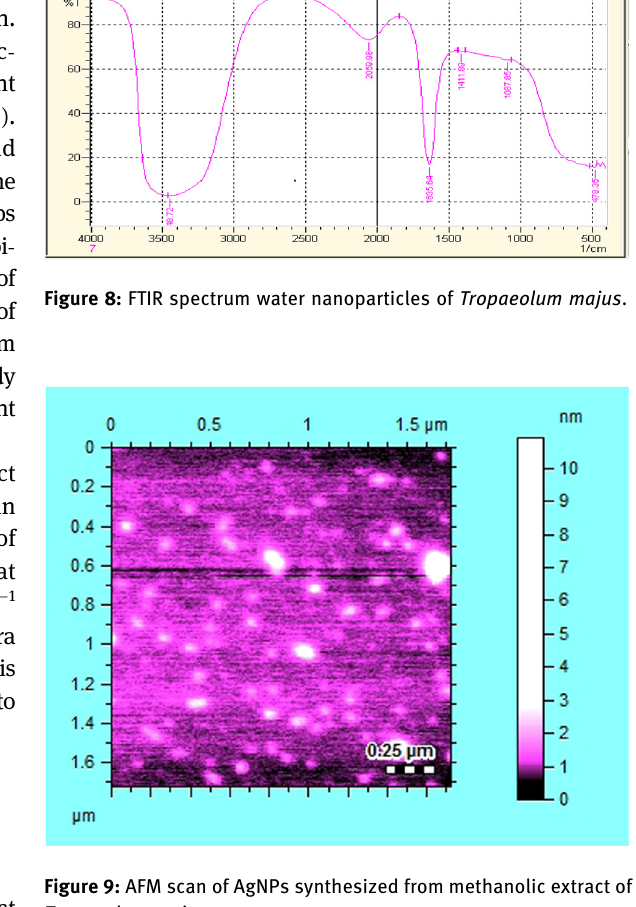
Figure 9: AFM scan of AgNPs synthesized from methanolic extract of Tropaeolum majus